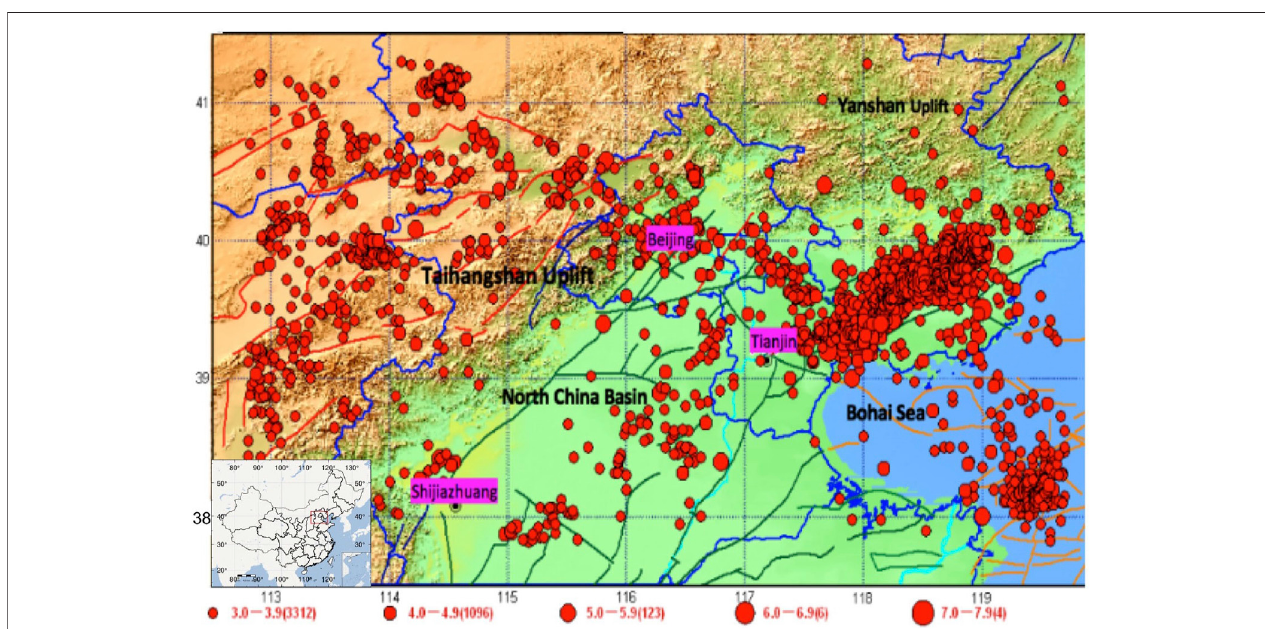
FIGURE 1 | Map showing the major geological background and related historical seismicity of North China. The color shows the surface topography. Red curved lines show major active faults, and blue curved lines show provincial boundaries. Red dots denote earthquakes with magnitudes (M) equal to or greater than 3 that occurred in the study area since BC 780. The earthquake magnitude scale and number are shown below the map. The insert map shows the location of the present study area. The red rectangular box indicates the study area in this paper.